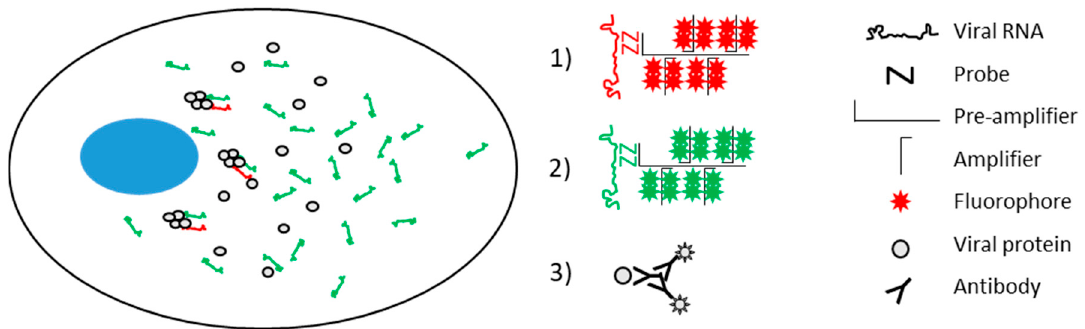
Figure 1. Schematic of the viral molecules in hepatitis C virus (HCV)-infected cells, and the signal amplification via RNAscope labeling of negative strand RNA (1) and positive strand RNA (2), and immunofluorescence detection of protein (3). Nucleus indicated in blue. Adapted from Wang et al. (2012) [8].